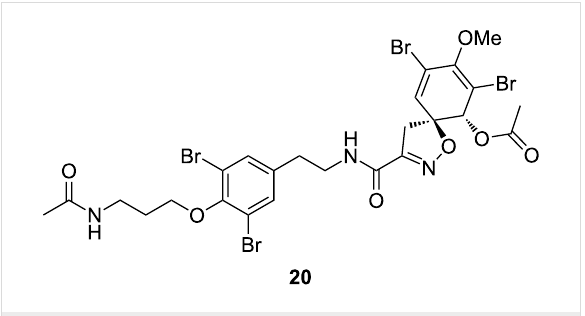
Figure 5: Diacetylhexadellin B ( 20 ) isolated from sponge Hexadella sp.